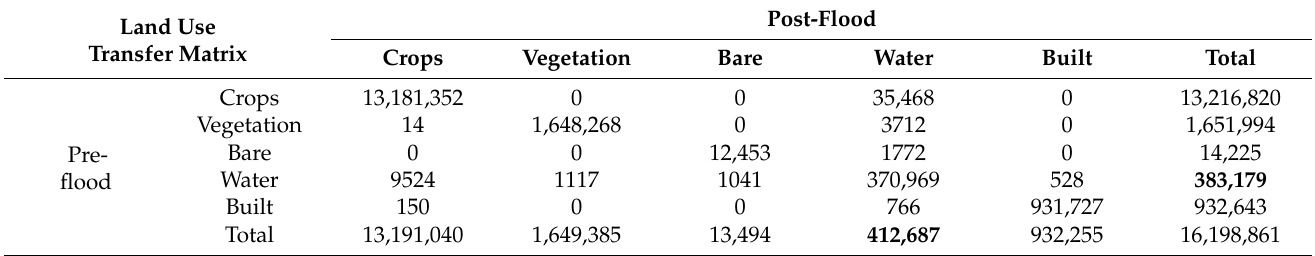
Table 3. Transfer matrix of land-use classification before and after the flood